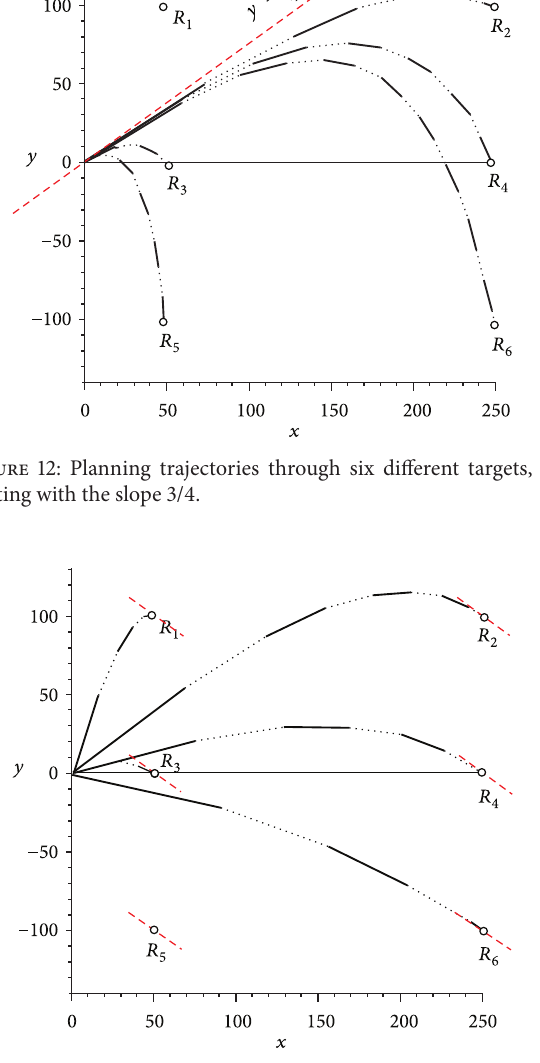
Figure 13: Planning trajectories through six different targets, all ending at the slope −